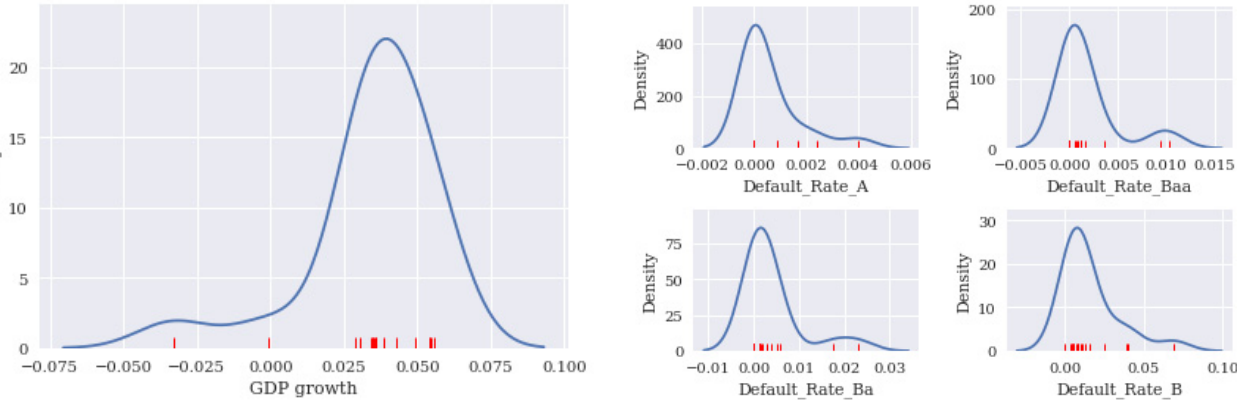
Figure 3. Kernel density estimates of GDP growth rate ( left panel ) and default rates ( right panel ) for ratings A, Baa, Ba, and B.